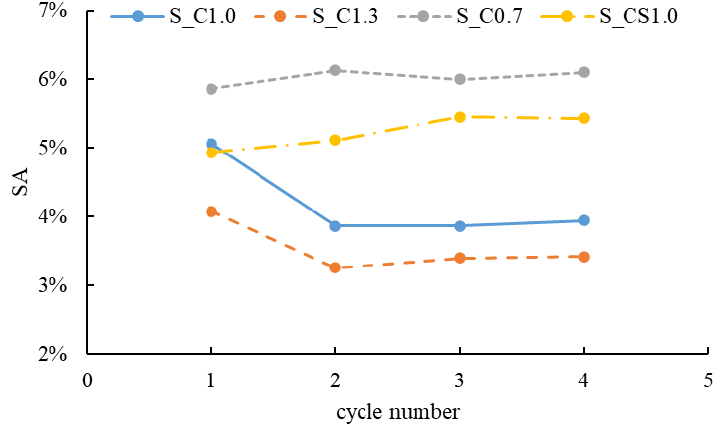
Figure 6. Relationships between the SA and the spraying cycle number of different slurries.